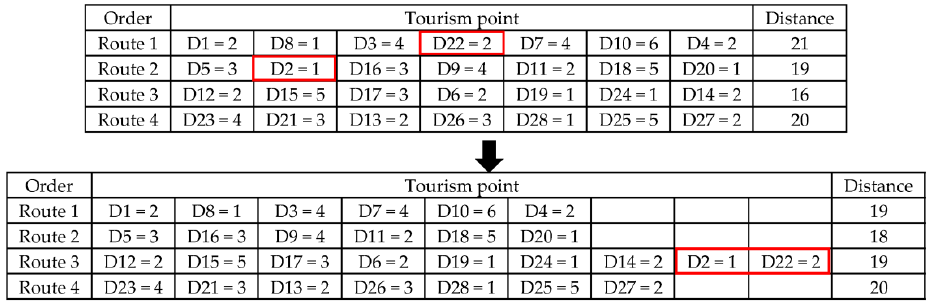
Figure 6. Example of two points of greedy